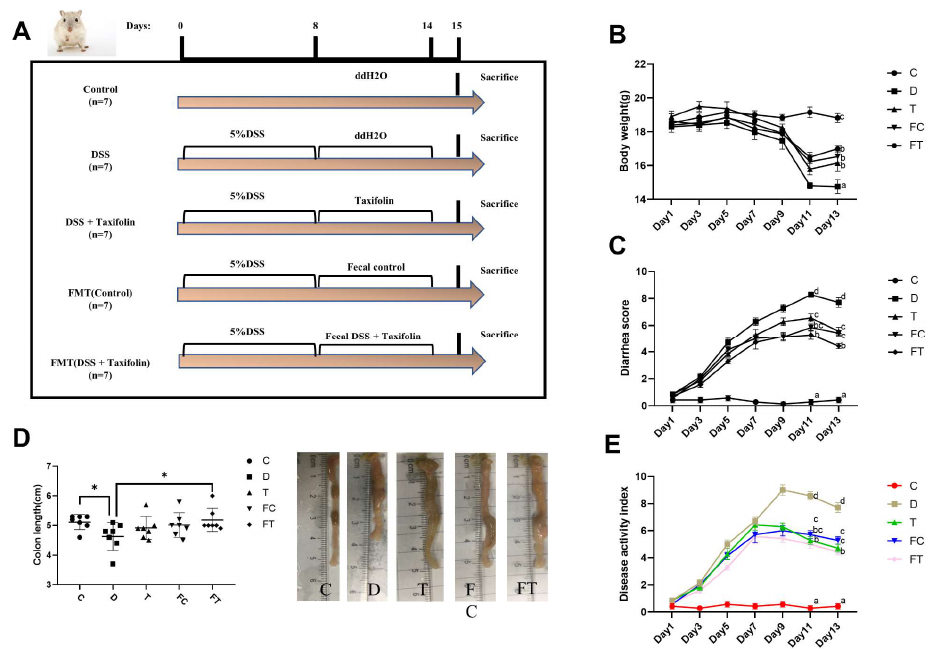
Figure 1. Taxifolin and FMT alleviated DSS-induced intestinal mucositis in mice. ( A ) Experiment design. The DSS group and DSS + Taxifolin and FC (FMT Control) and FT(FMT DSS + Taxifolin) group mice were intraperitoneally administered with DSS (5%) once daily for 7 days (days 1–7). The control group mice were orally administered with ddH2O. Meanwhile, the DSS + Taxifolin group were treated with Taxifolin (200 mg/kg in ddH 2 O) by oral gavage once daily for 7 days (days 8–14) and FC and FT were treated with 150 μL fecal suspension (100 mg/mL) from control and DSS + Taxifolin group respectively. ( n = 7) ( B ) Body weight loss after DSS administration were significantly repressed after Taxifolin or FMT treatment. ( C ) Mice treated with Taxifolin or FMT had a significantly lower score of diarrheas compared with DSS group, especially in day11 and day13. ( D ) Taxifolin treatment reduced the loss of colon length caused by DSS treatment. ( E ) DAI scores for experimental procedures in mouse. Values were expressed as mean ± SEM (B–D: n = 7) * p < 0.05, The letters abcd are significant markers, and any difference with one of the same marker letters is not significant, and any difference with different marker letters is significant.